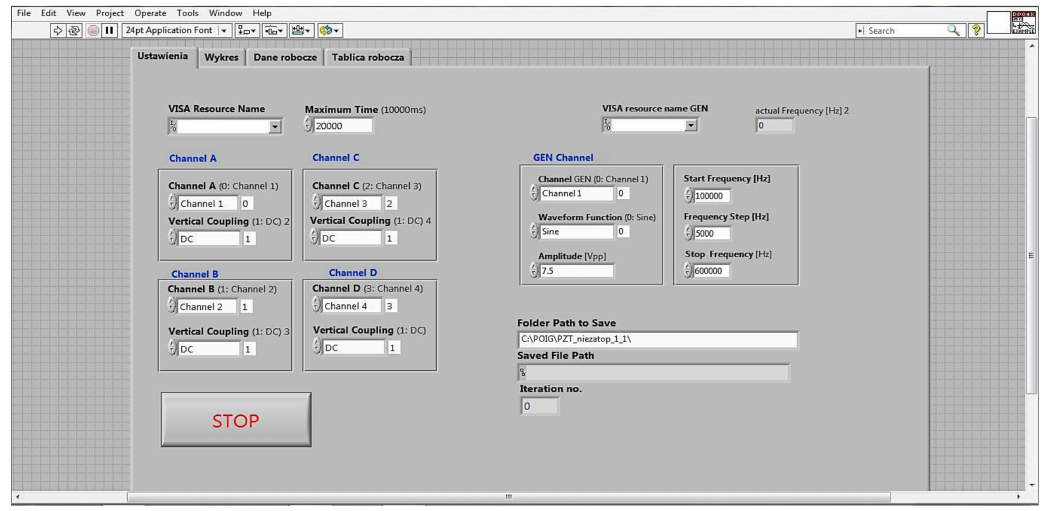
Figure 8. The front panel of the developed computer program—the settings window of the oscilloscope and the function generator parameters.